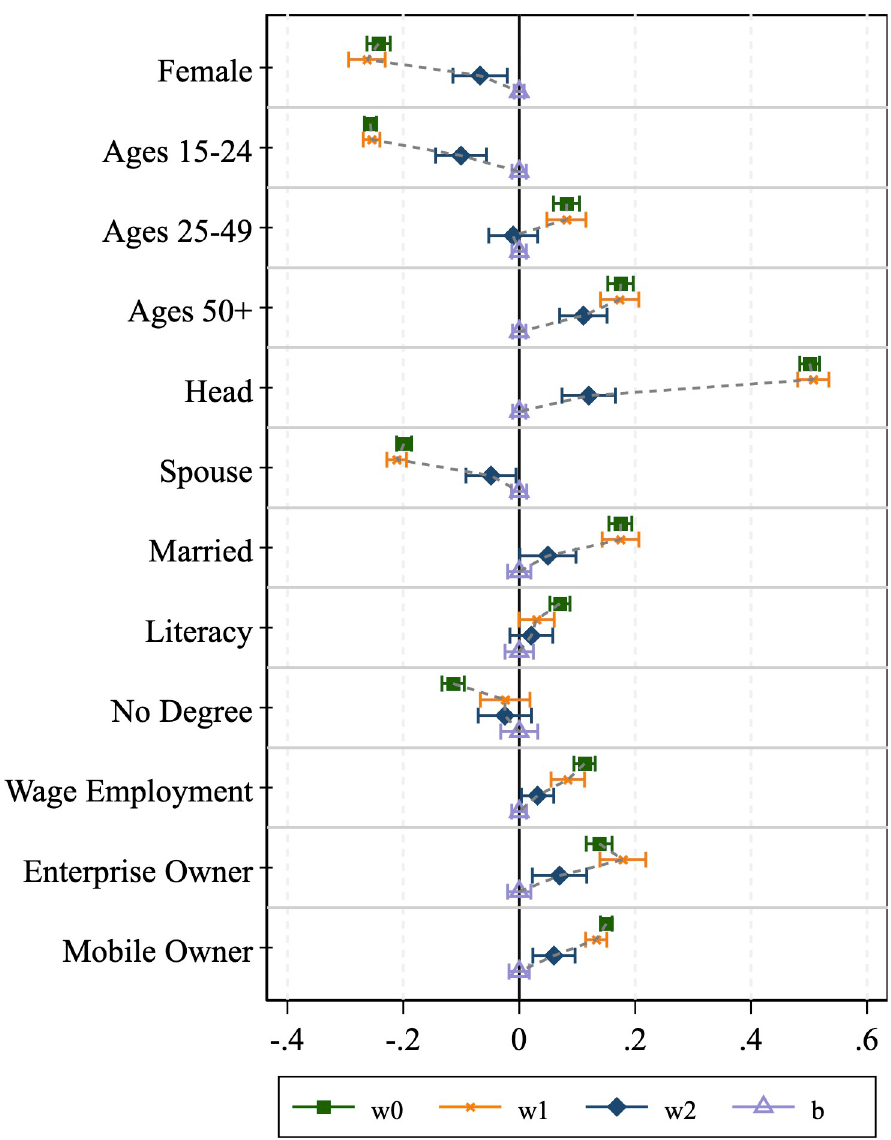
Fig 3. Graphical inspection of bias adjustment,